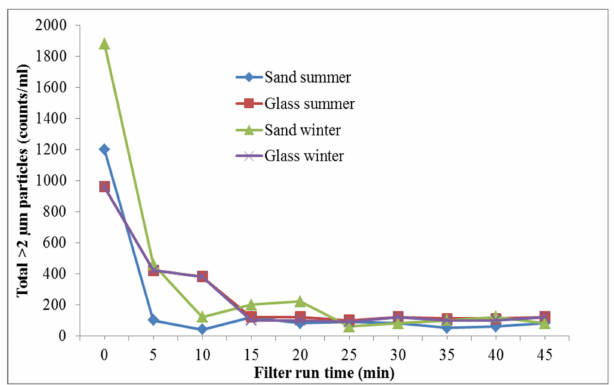
Figure 7. Ripening times in winter and summer conditions (reprepared using the data from